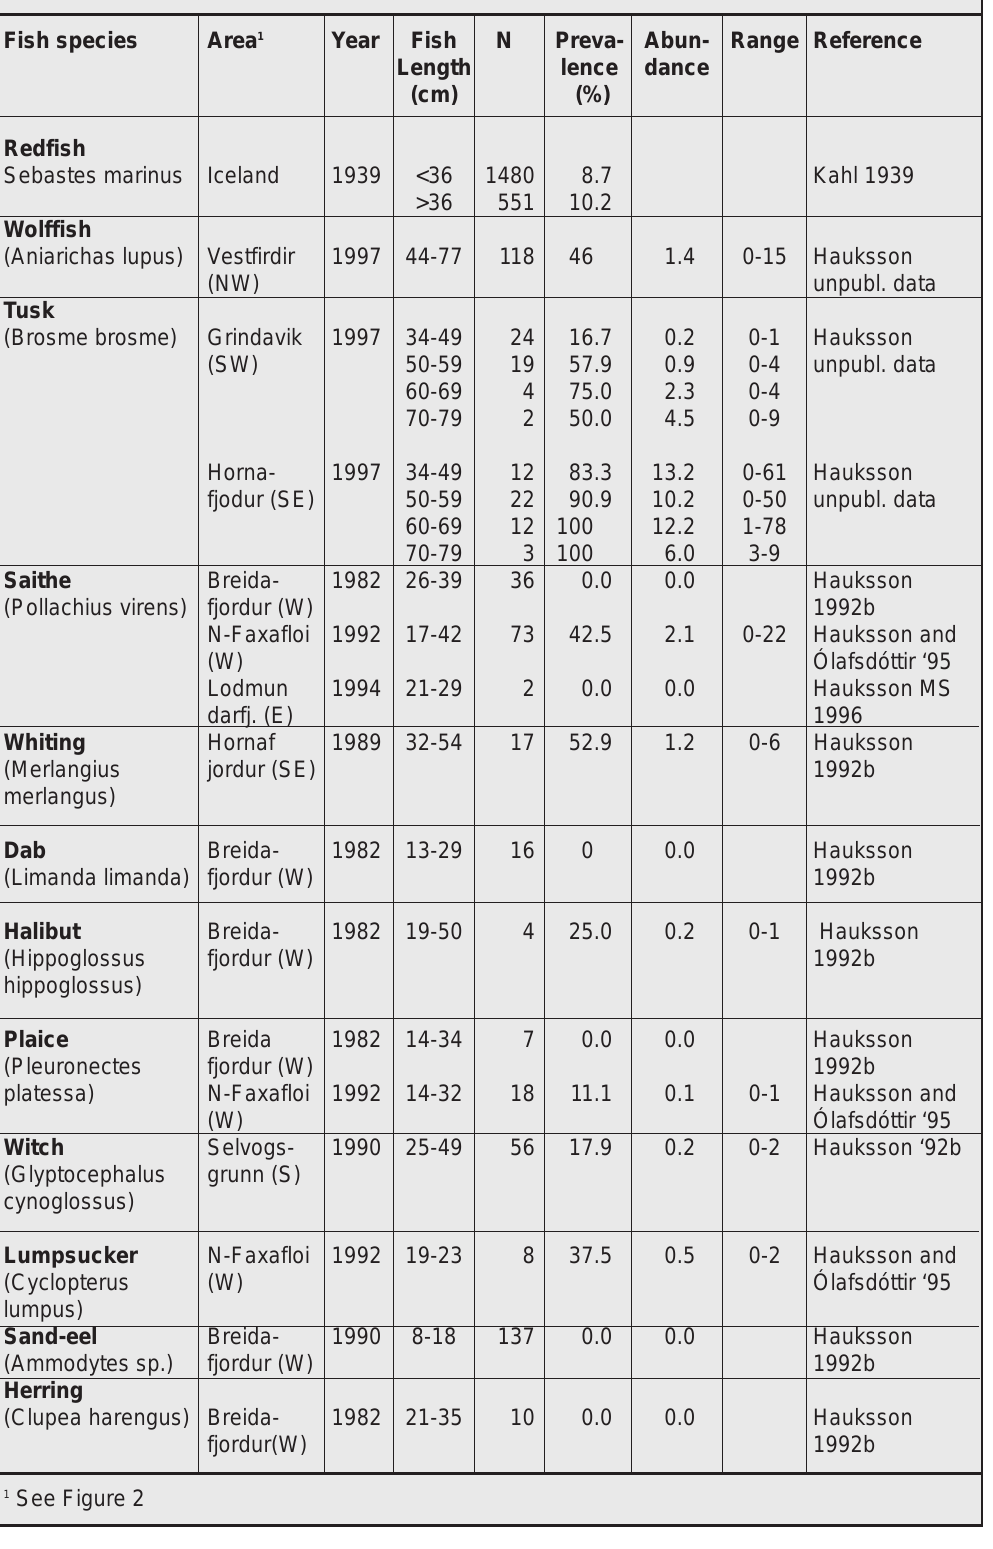
Table 5 . Characteristics of sealworm ( Pseudoterranova decipiens ) infections in stomachs of grey seals ( Halichoerus grypus ) in Icelandic waters in 1989-93. 1 (Ólafsdóttir and Hauksson